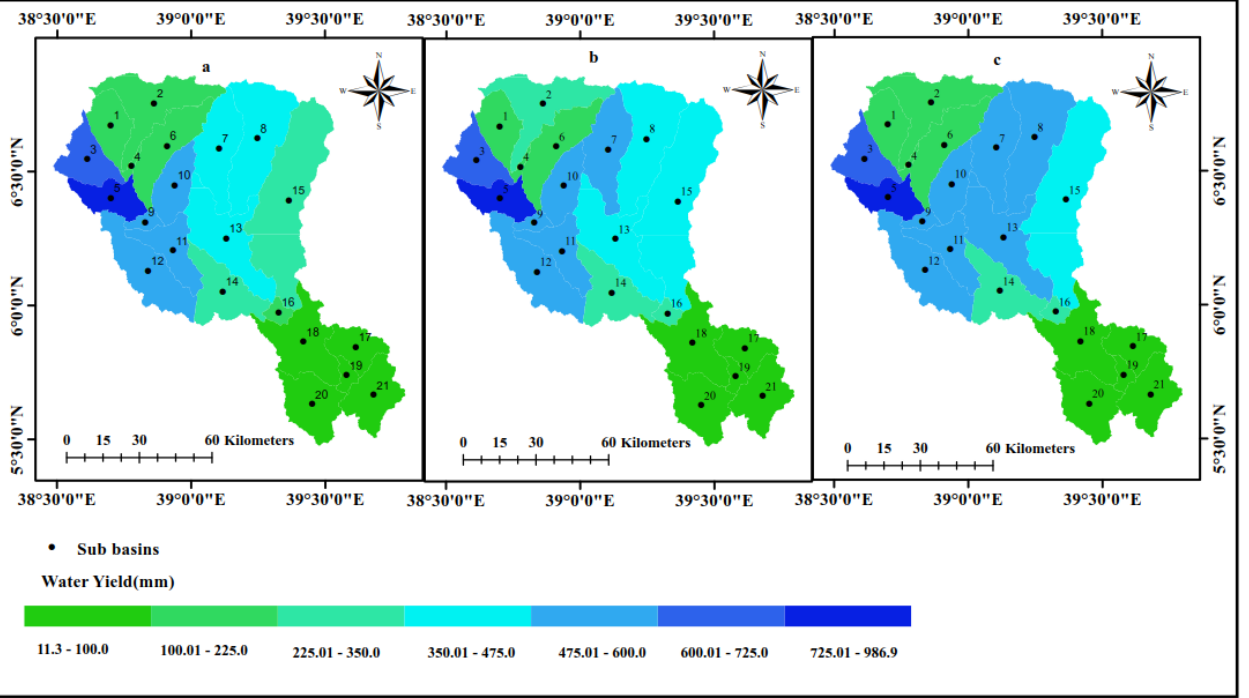
Figure 10. Simulated spatial distribution of evapotranspiration for ( a ) 1986, ( b ) 2001, and ( c ) 2016 LULC scenarios.